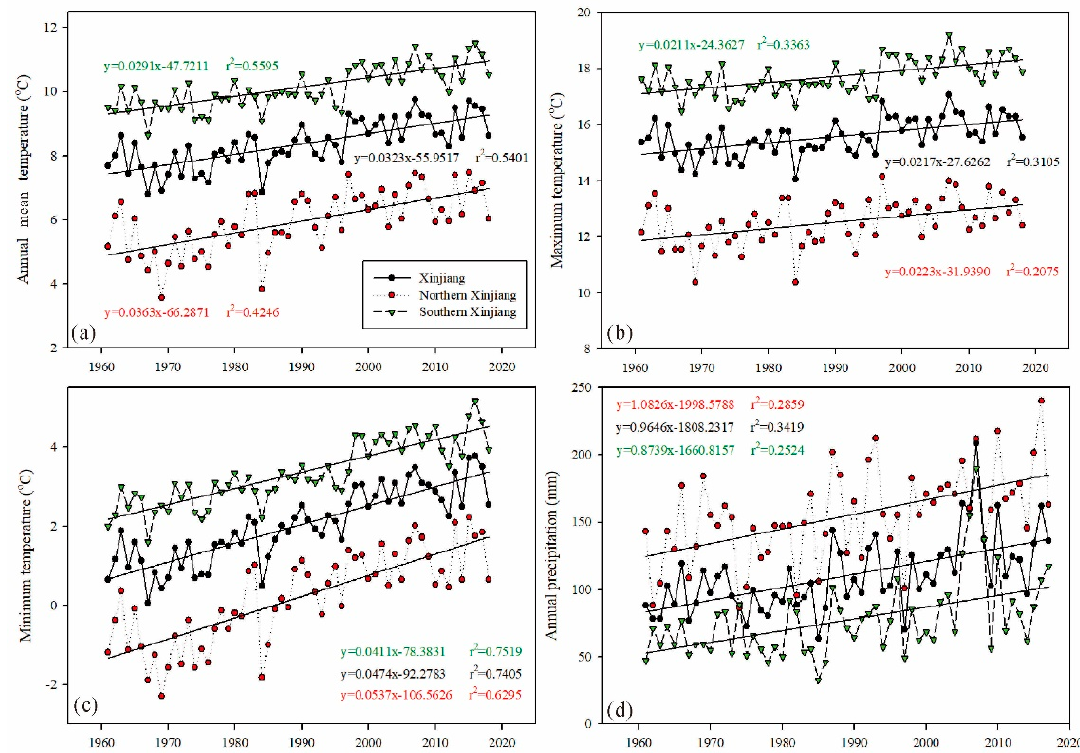
Figure 4. Changes of the ( a ) annual mean temperature, ( b ) maximum and ( c ) minimum temperature from 1961 to 2018, and ( d ) annual precipitation from 1961 to 2017, in the whole, the northern, and the southern Xinjiang.